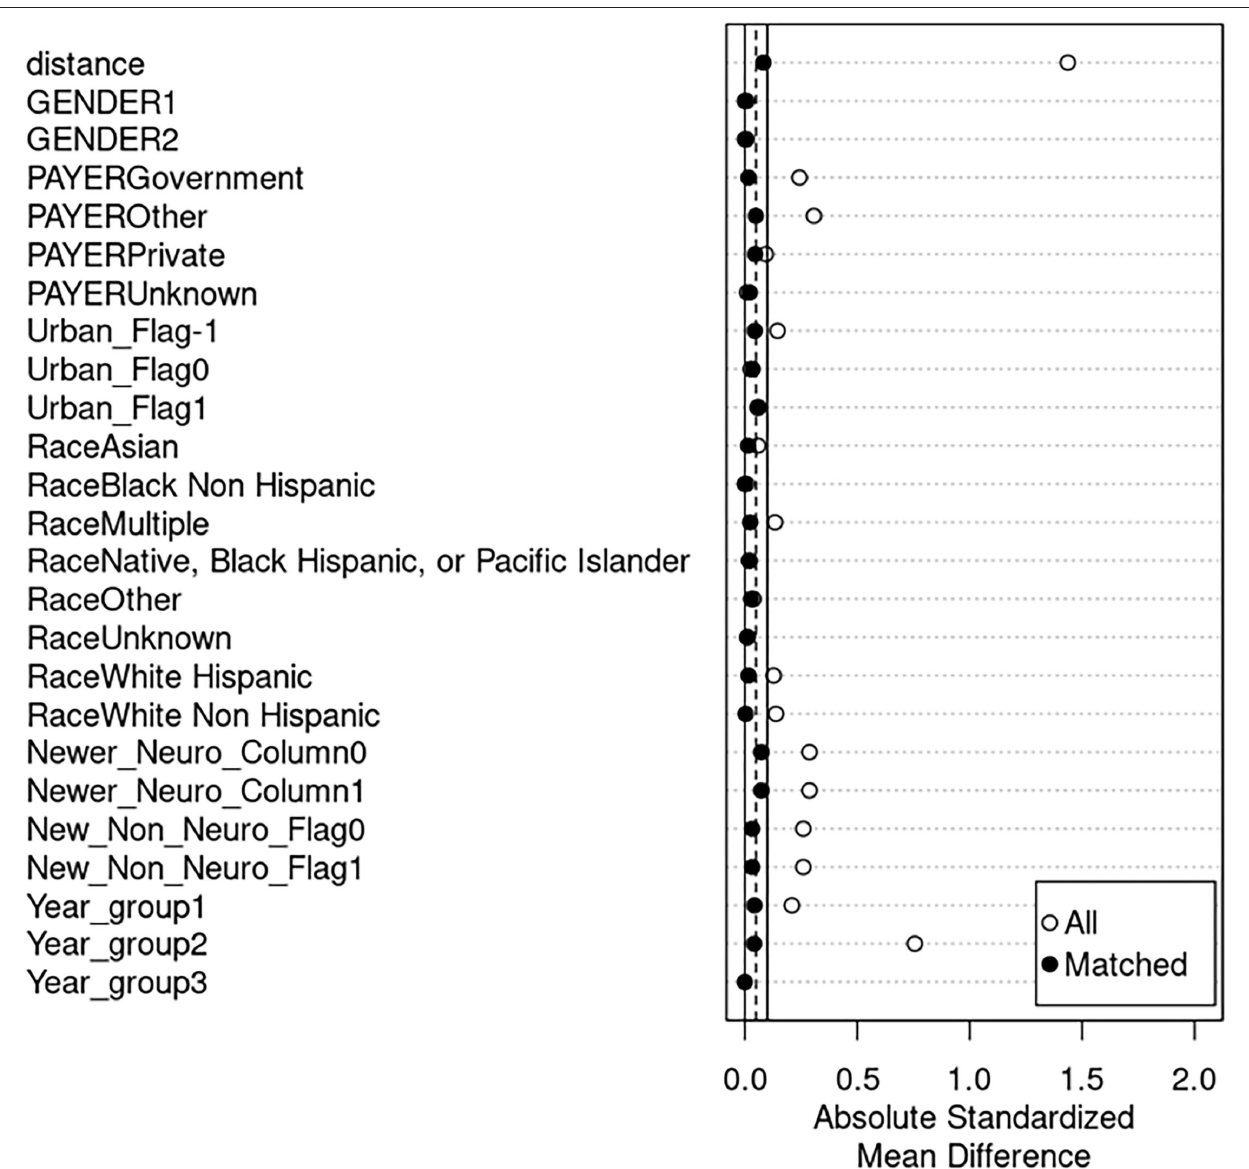
FIGURE 2 | Propensity score matching. Differences in means (y-axis) are shown between the adrenocorticotropic hormone (ACTH) and prednisolone/prednisone (PRED) drug cohorts for covariates before and after matching. Before matching (indicated by white dots), the absolute standardized difference in means has higher values, indicating a higher difference between the cohorts for certain covariates. Following matching (indicated by black dots), the values for the absolute standardized mean difference decrease, indicating a higher degree of similarity between the cohorts when comparing variable frequencies. “Distance” indicates the absolute difference between the propensity scores of matching